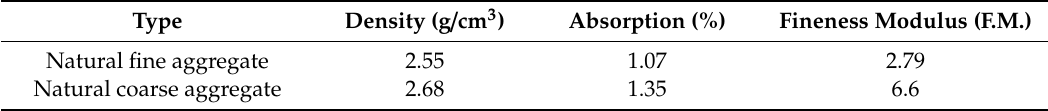
Table 2. Material properties of the natural